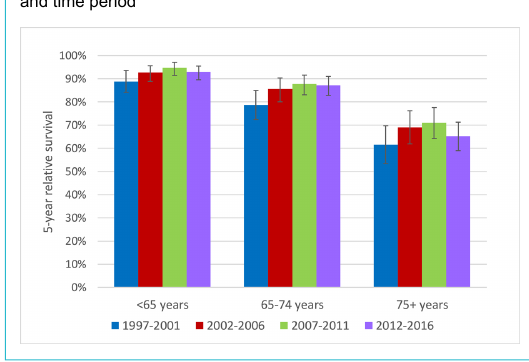
Figure 4: Relative 5-year survival after chronic lymphocytic leukaemia / small lymphocytic lymphoma diagnosis by